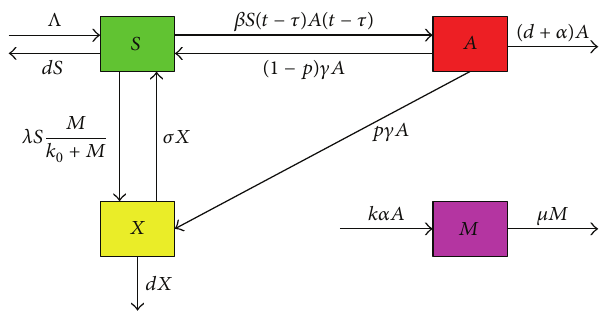
Figure 1: The transfer diagram of system